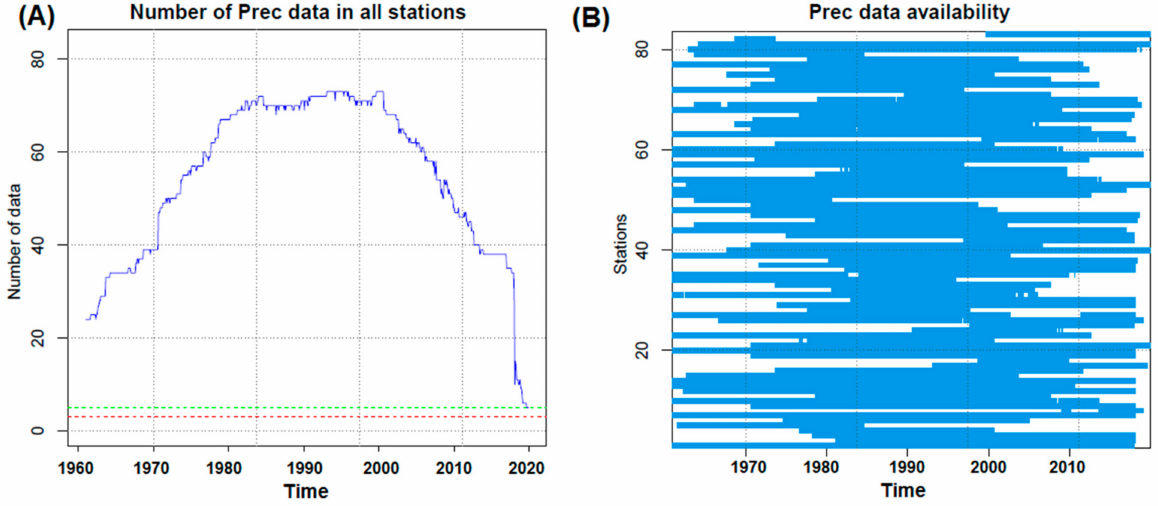
Figure 3. Data availability per year. The green and red lines mark respectively the desired and critical number of data availability